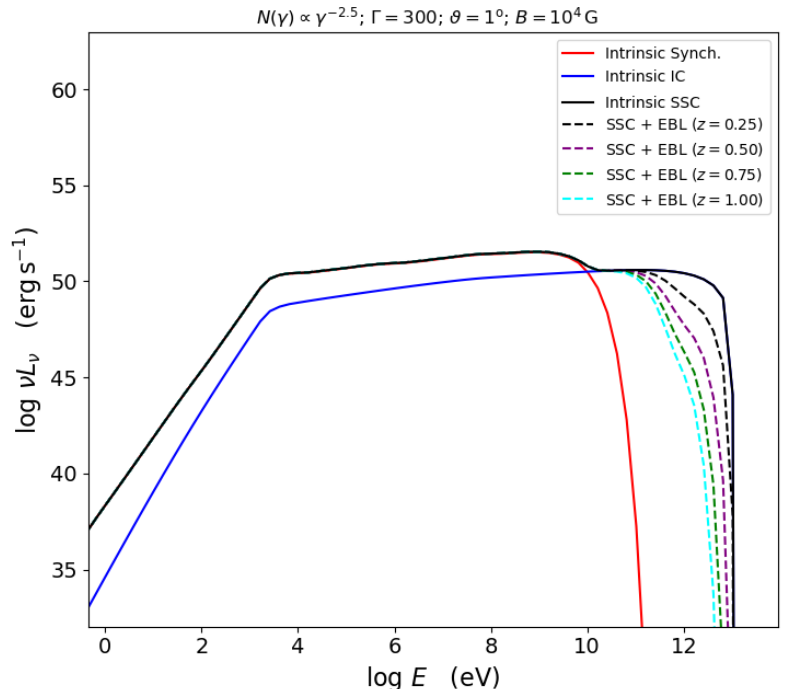
Figure 1. Spectral energy distribution expected for a relativistic blob of plasma, with bulk Lorentz factor Γ = 300, moving with an inclination of ϑ = 1 o from the line of sight and carrying a magnetic field B = 10 4 G. The radiating particles are assumed to be electron-positron pairs in a power-law distribution N ( γ ) ∝ γ − 2.5 , with 10 (cid:54) γ (cid:54) 10 6 . The red line represents synchrotron emission, while the blue line shows the inverse Compton scattering contribution. The resulting spectrum is represented as a continuous black line. The dashed curves illustrate the effects of γγ -opacity on the Universe background radiation for redshifts 0.25 (cid:54) z (cid:54) 1, in steps of